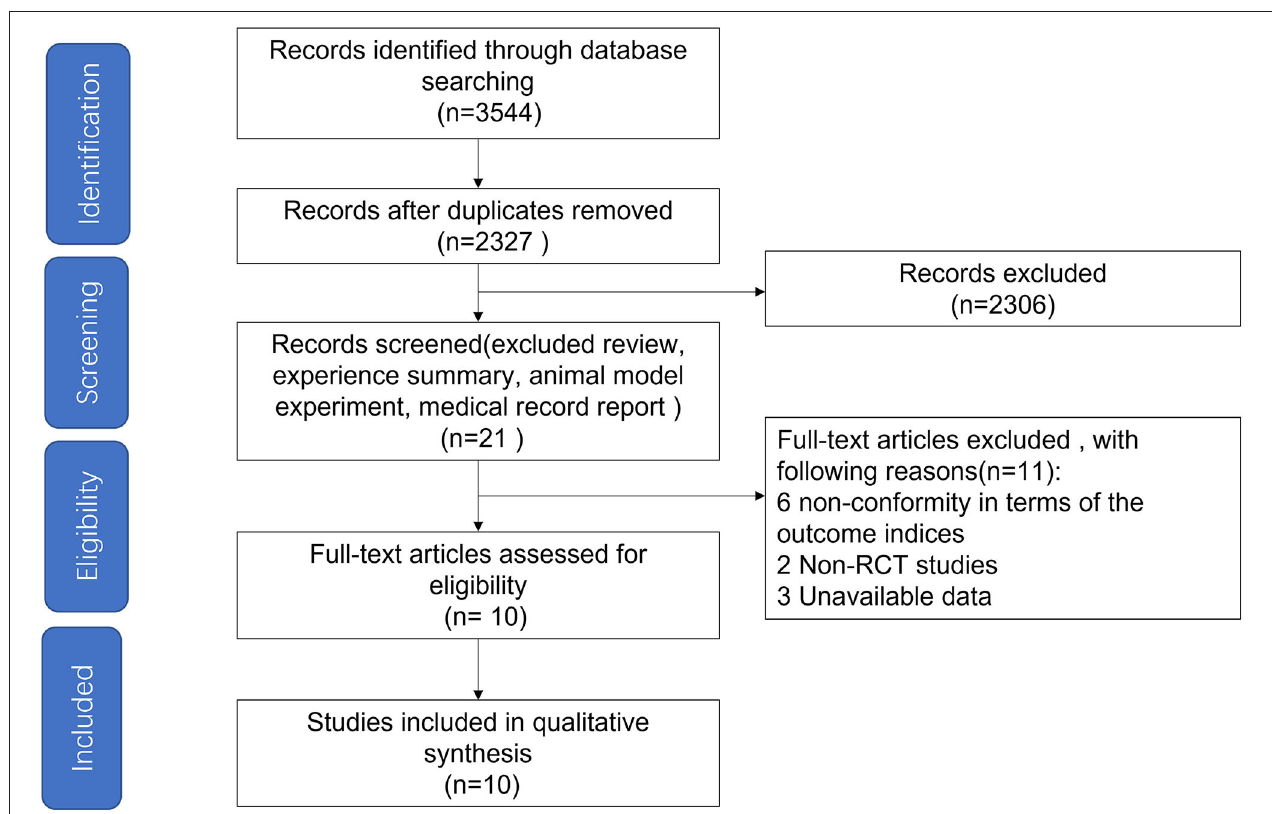
FIGURE 1 | Flow diagram depicting the article search and selection strategy. A total of 10 articles were included in the